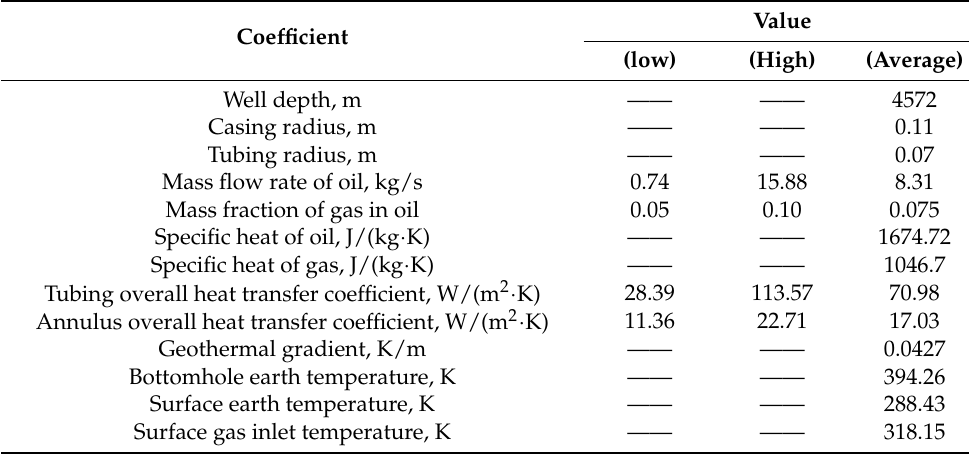
Table 1. Range of Sensitive Parameter